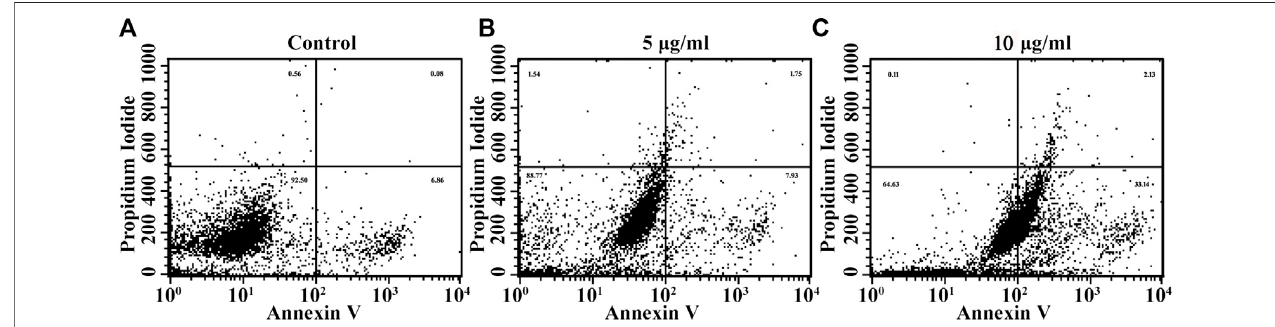
FIGURE9|(A – D) Apoptoticcell deathinduced duetoAg-NPs treatments inHeLacells after24 hincubation wasassessed usingAnnexin VFITC/PI dualstaining. The percentage of early and late apoptotic cell population in the control group found to be lower, and the viable cell count was higher in control cells compared with Ag-